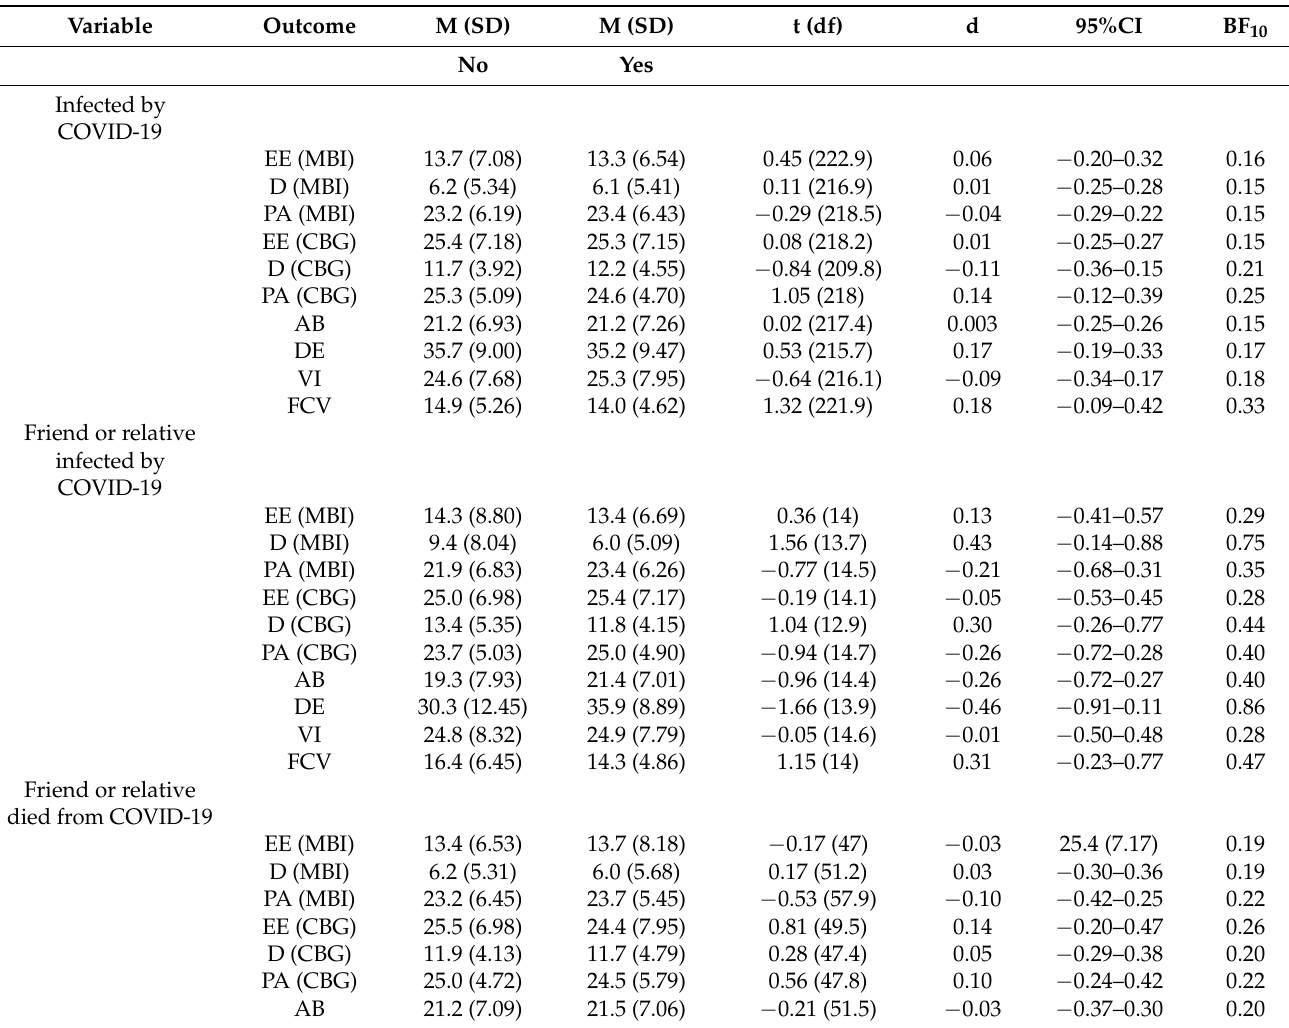
Table 4. Results of the hypothesis tests of differences in burnout and engagement according to the coronavirus-related variables, for the second